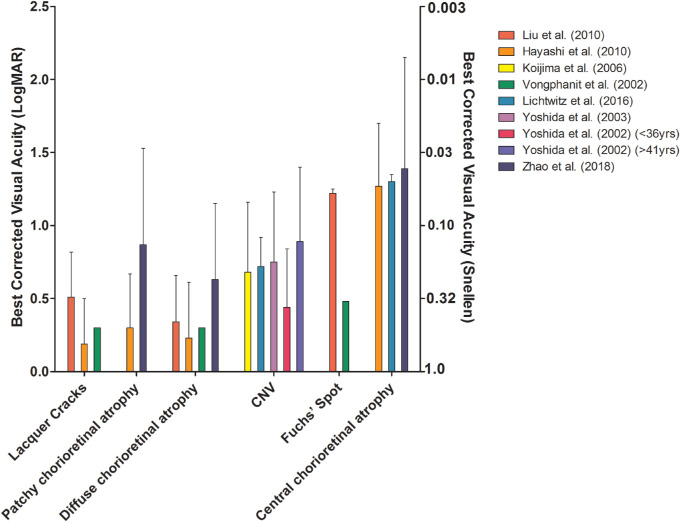
BCVA in eyes with different stages of MMD.